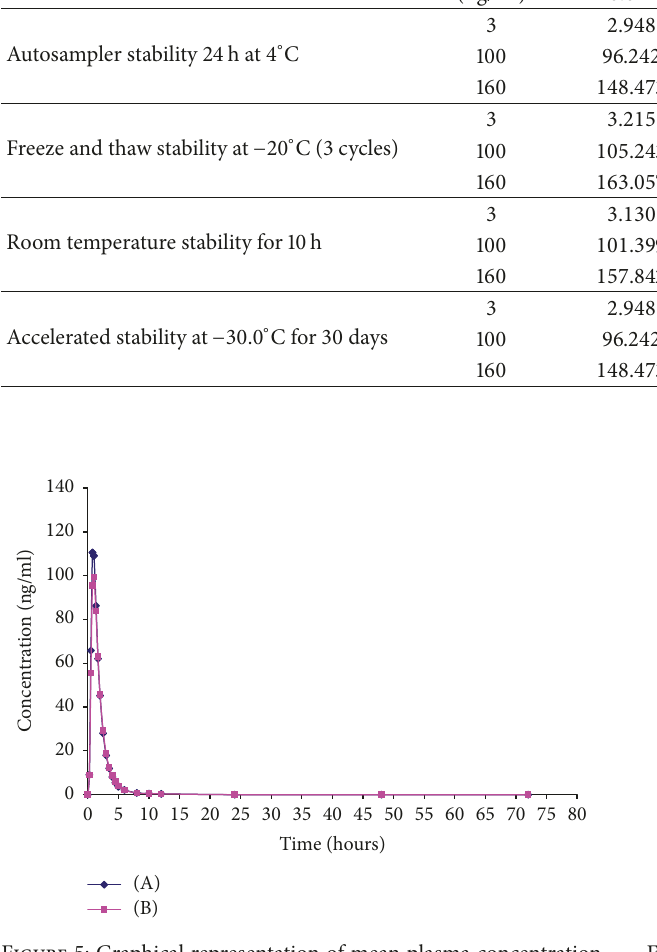
Figure 5: Graphical representation of mean plasma concentration versus time of enalapril following 20 mg single oral dose of test (B) and reference preparation (A) to 30 healthy human volunteers.